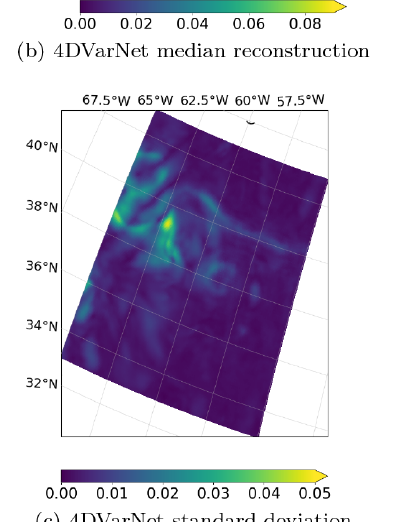
Figure 12. Interpolation performance of an ensemble of nine 4DVarNet-SSH models trained using similar training parameters (number of epochs, learning rates, optimizers, gradient steps, etc.) but different random initialization of both (cid:56) and (cid:48) weights. (a) Spa- tial RMSE time series on the BOOST-SWOT DC evaluation period, (b) 4DVarNet median run (25 October 2012; GULFSTREAM do- main), and (c) its spatial standard